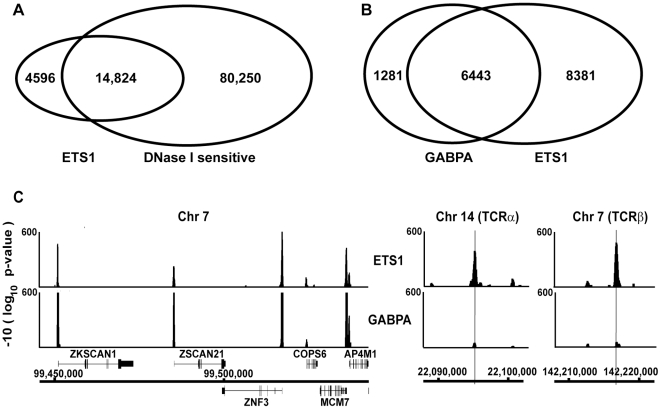
Genomic occupancy of ETS1 overlaps with DNase I sensitivity and GABPA occupancy.(A) Overlap of genomic regions bound by ETS1 in Jurkat T cells and regions found to be DNase I sensitive in CD4+ T cells [19]. (B) Overlap of regions occupied by ETS1 and GABPA in Jurkat T cells [23]. Only regions that overlap with DNase I sensitivity were included. (C) Log transformed P values of ETS1 and GABPA occupancy in a scanning 250 bp window mapped using the Integrated Genome Browser (http://igb.bioviz.org/) to regions of the human chromosome (Chr) indicated by chromosomal coordinates (NCBI Build 36.1). Positions of Refseq genes are shown with genes transcribed from left to right above the nucleotide position bar and genes in the opposite orientation below. Vertical lines (right) indicate the ETS/RUNX binding sequences previously tested for function [27],[44] in the TCRα enhancer (sequence GAGGATGTGGC) or the TCRβ enhancer (sequence CAGGATGTGGT).